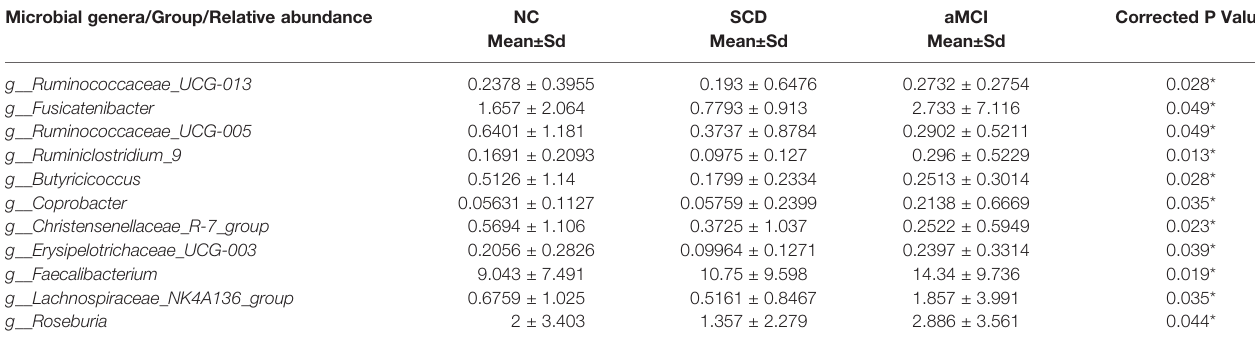
TABLE 4 | Relative abundance of intestinal microbiota genera between different cognitive groups. Microbial genera/Group/Relative